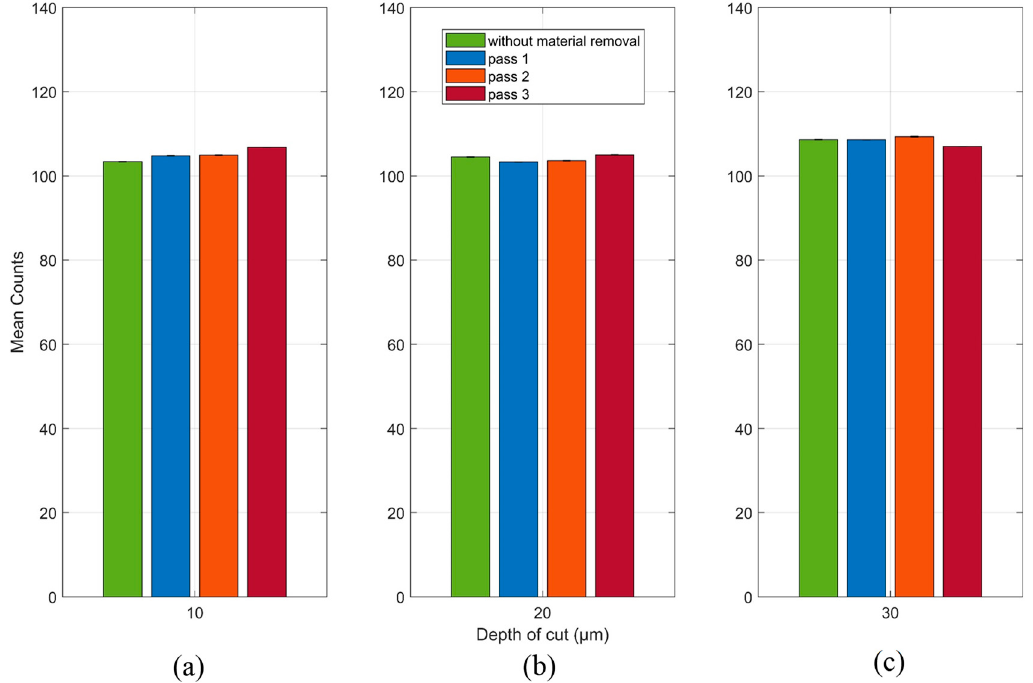
Figure 9. Counts mean and standard deviation values of the raw unfiltered signals at ( a ) 10 µm, ( b ) 20 µm and ( c ) 30 µm.